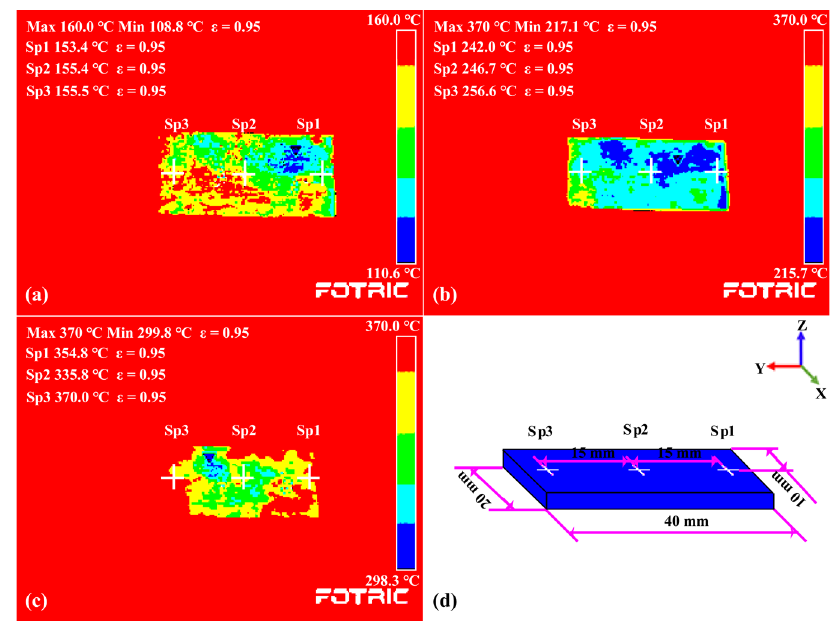
Figure 2. Schematic diagram of LC process.